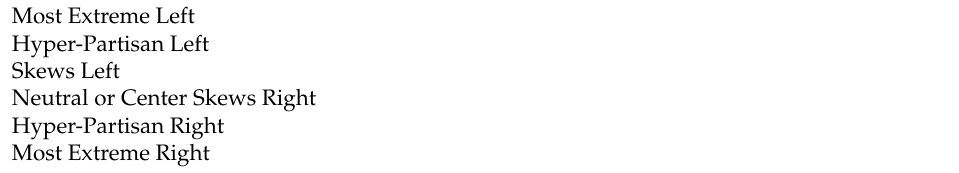
Table 1. Media Political